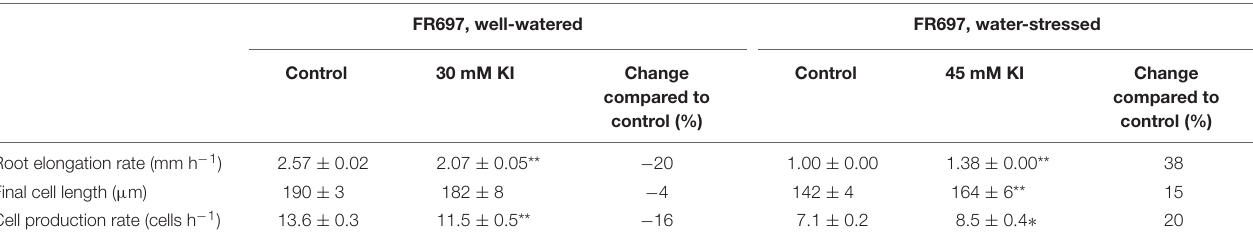
TABLE 4 | Elongation rate, final cell length, and cell production rate of control and KI-treated primary roots in line FR697 at 36 h after transplanting to well-watered or water-stressed ( − 1.6 MPa)